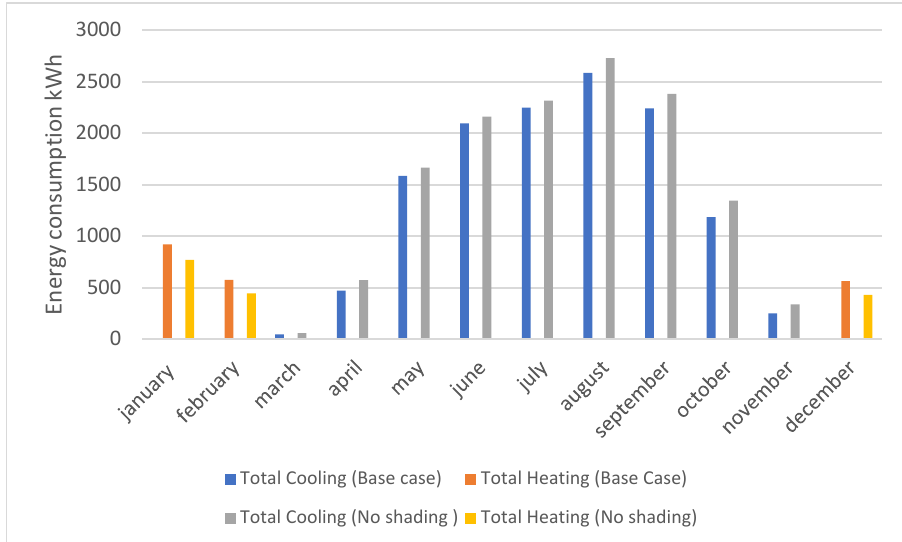
Figure 18. Hail Tradition house without courtyard corridor (Case 2).